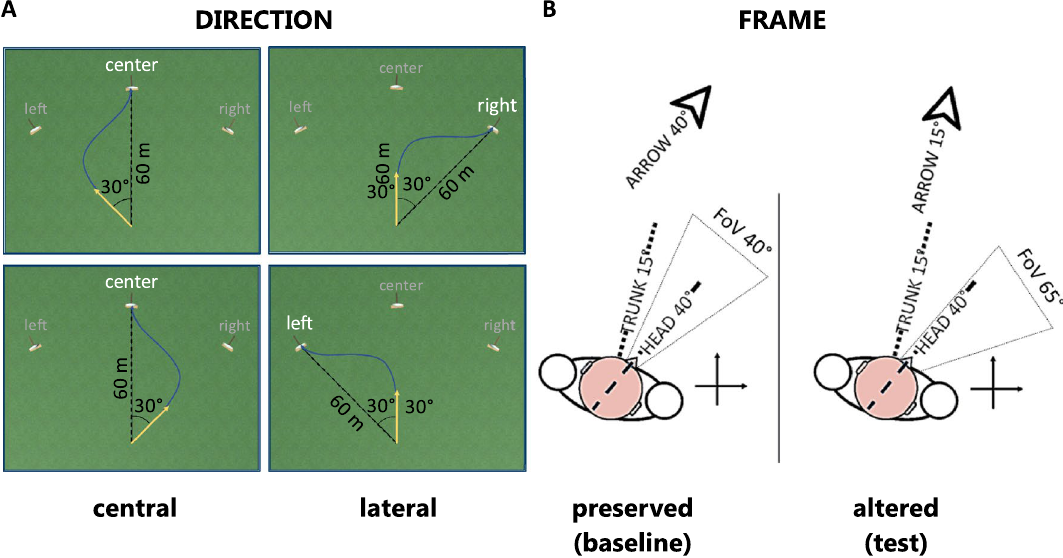
Figure 1. In panel ( A ), elements in the virtual environment and their metric relationships depending on the "direction" factor levels, with examples of possible arrow trajectories (blue full lines). The yellow arrow highlights the starting arrow direction. Targets with dark grey names are inactive during the trial; the only active target is the one with white text. Examples on the same rows show conditions where the relative position of arrow and target is the same, but the absolute target position (i.e., the "direction" level) is different. In panel ( B ), example of relationship between head, trunk, field of view and arrow for the two conditions under investigation in the present